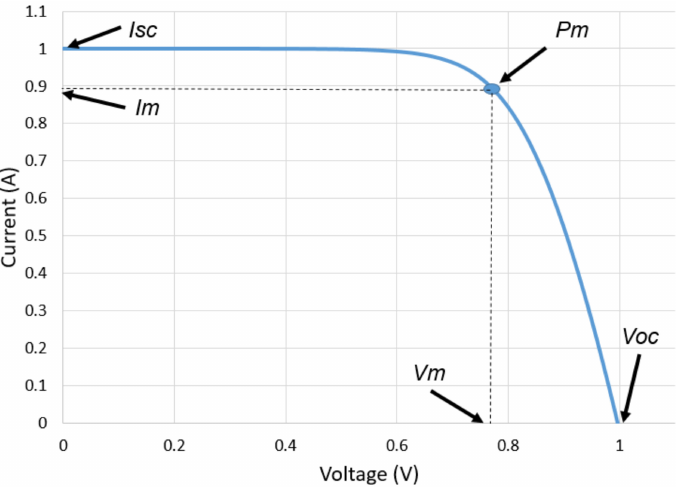
Figure 1. Normalized I–V curve of a photovoltaic